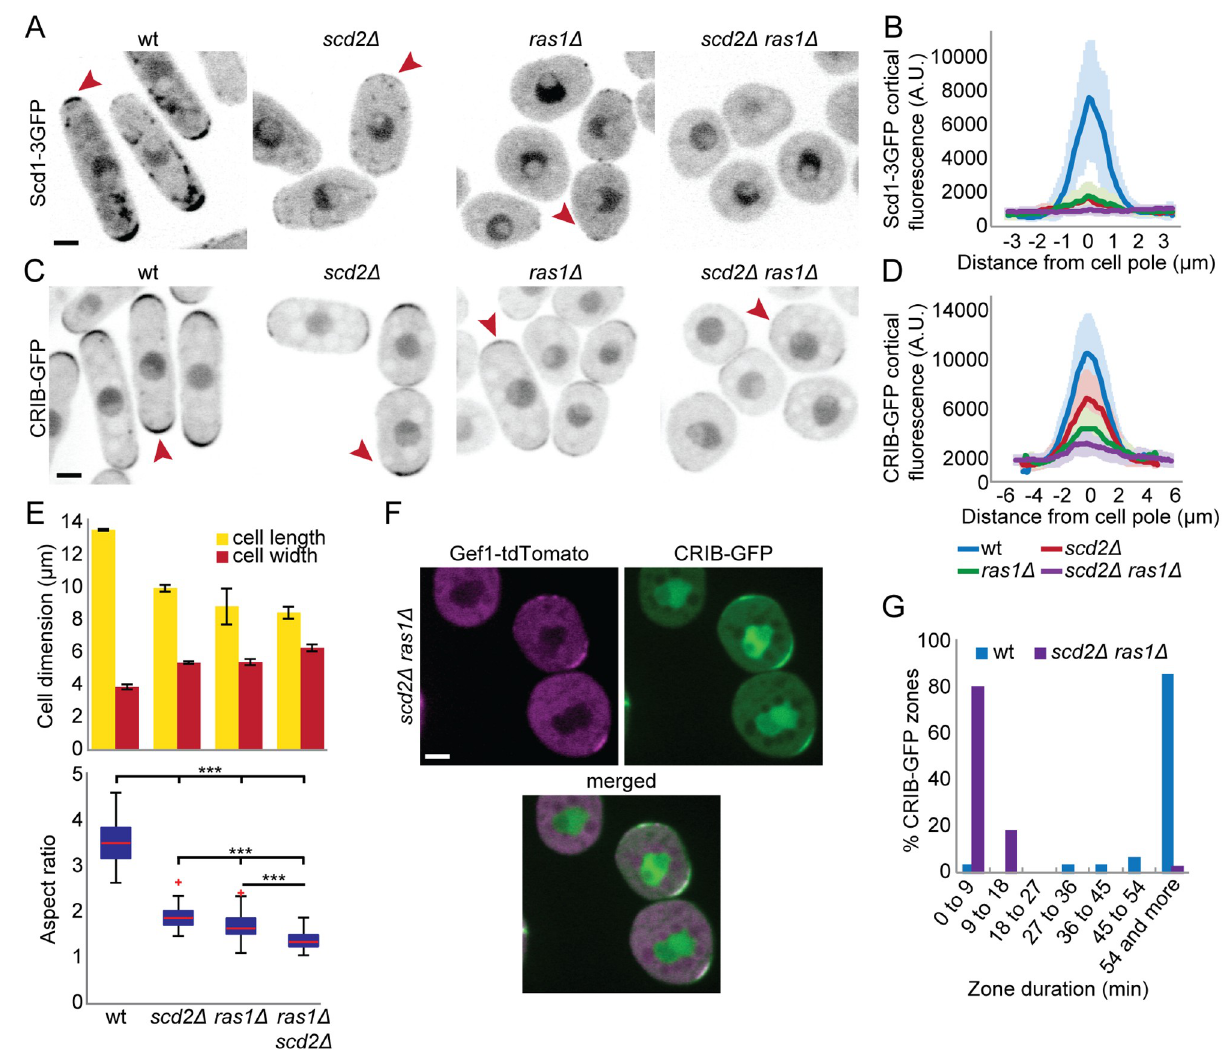
Fig 1. Ras1 and Scd2 cooperate for Scd1 recruitment to cell poles. (A-D) Localization of Scd1-3GFP (A-B) and CRIB-GFP (C-D) in wt, ras1 Δ , scd2 Δ , and ras1 Δ , scd2 Δ cells. (A) and (C) show representative B/W inverted images; (B) and (D) show cortical tip profiles of Scd1-3GFP and CRIB-GFP fluorescence; n = 24 and 26 cells, respectively. Thick line = average; shaded area = standard deviation. (E) Mean cell length and width at division (top) and aspect ratio (bottom) of strains as in (C) ( n > 30 for 3 independent experiments). Bar graph error bars show standard deviation; box plots show the ratio between cell length and cell width. On each box, the central mark indicates the median; the bottom and the top edges indicate the 25th and 75th percentiles, respectively; the whiskers extend to the most extreme data points not considering outliers, which are plotted individually using the red “+” symbol. ��� indicates 2.8e -90 � p � 1.9e -10 . (F) Colocalization of CRIB-GFP and Gef1-tdTomato in ras1 Δ scd2 Δ double-mutant cells. Bar = 2 μ m. (G) Lifetime of CRIB-GFP cortical zones over 1 h, in wt and ras1 Δ scd2 Δ cells ( n = 32 and 39 zones respectively). All underlying numerical values are available in S1 Data. A.U., arbitrary units; B/W, black and white; wt, wild type.